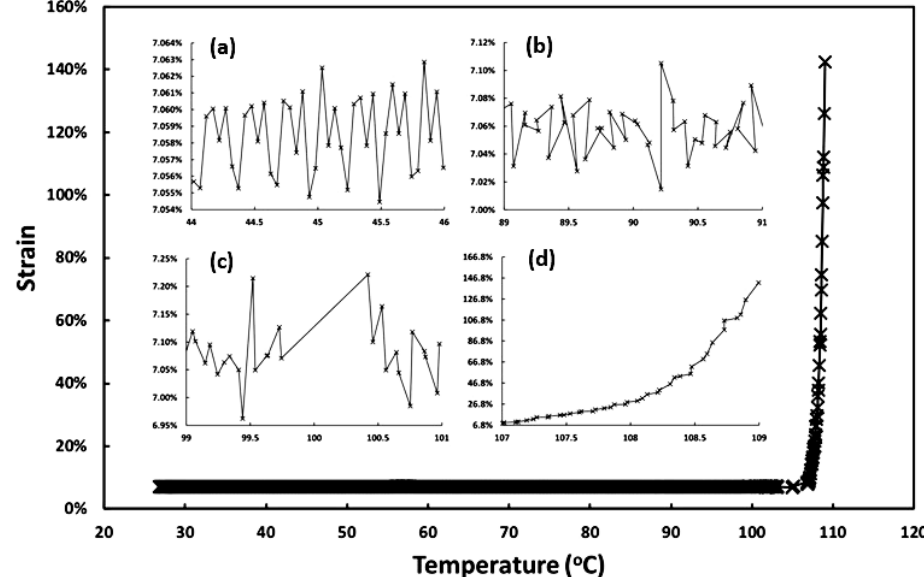
Figure 5. Strain versus heating temperature relationship in DMA test (same set of experimental data for Figure 4). ( a ): Zoom-in view from 44 ◦ C to 46 ◦ C; ( b ) zoom-in view from 89 ◦ C to 91 ◦ C; ( c ) zoom-in view from 99 ◦ C to 101 ◦ C; ( d ) zoom-in view from 107 ◦ C to 109 ◦ C.